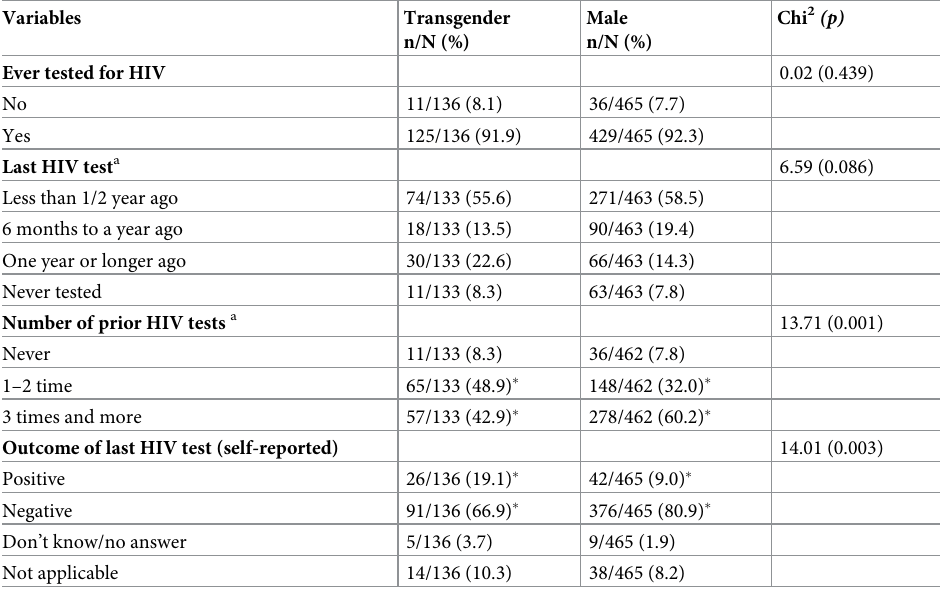
Table 3. HIV testing by gender identity among persons screened for participation in HPTN 075 (N = 601).